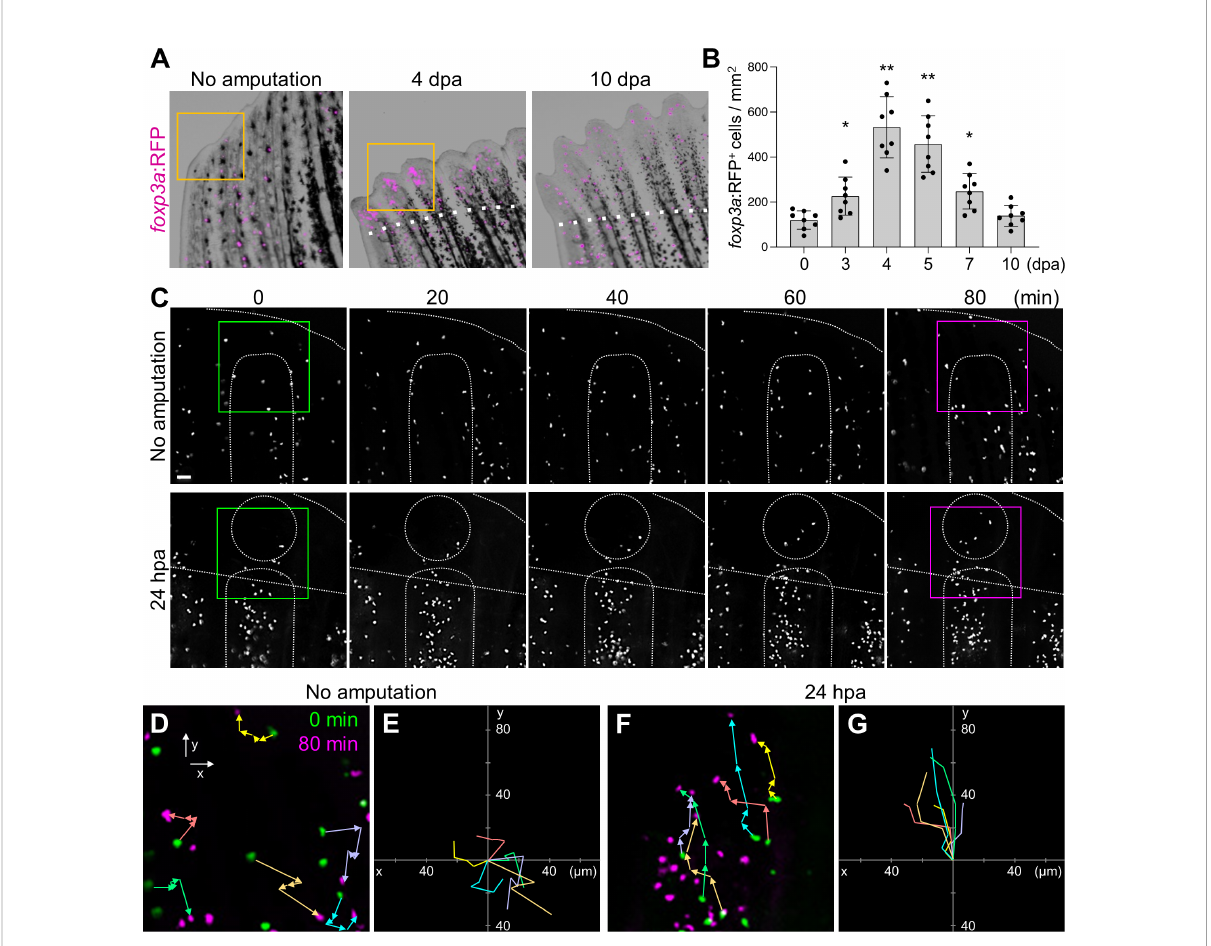
FIGURE 1 Amputation-induced in fi ltration of Tregs in the regenerating caudal fi n tissue. (A) Spatio-temporal distribution of foxp3a: RFP+ Treg cells in the distal part of unamputated, 4 and 10 days post amputation (dpa) regenerating caudal fi ns. Dotted lines show the plane of amputation. Yellow box indicates the distal tip of unamputated fi n or regenerating fi n blastema. Bar, 200 µm. (B) Quanti fi cation of foxp3a: RFP+ cells in unamputated, 3, 4, 5, 7 and 10 dpa fi ns (mean ± SEM, n = 8, *P < 0.01, **P < 0.001, Mann – Whitney U test). (C) Time-lapse images of foxp3a: RFP + cells in unamputated or 24 hours after amputation (hpa) of caudal fi n. Dotted lines demarcate the distal tip, the bone, the blastema, and amputation planes. Bar, 20 µm. (D, F) Higher magni fi cation fi elds of C in unamputated and 24 hpa fi n respectively. foxp3a: RFP+ cells at 0 min and 80 min are indicated by green and magenta, respectively. Colored arrows correspond to the migratory tracks of each foxp3a: RFP+ cells in unamputated (D) and 24 hpa fi n (F) . Bar, 20 µm. (E, G) Combinatorial overlay of the 6 individual tracks of foxp3a: RFP+ cell in (D, F) , respectively, and which were plotted after aligning their starting positions. Each crawling tracks display a migratory path for individual Treg cells. The traces shown in (D, F) are repositioned to the center to de fi ne the migratory path distance of each dot. Bar, 20